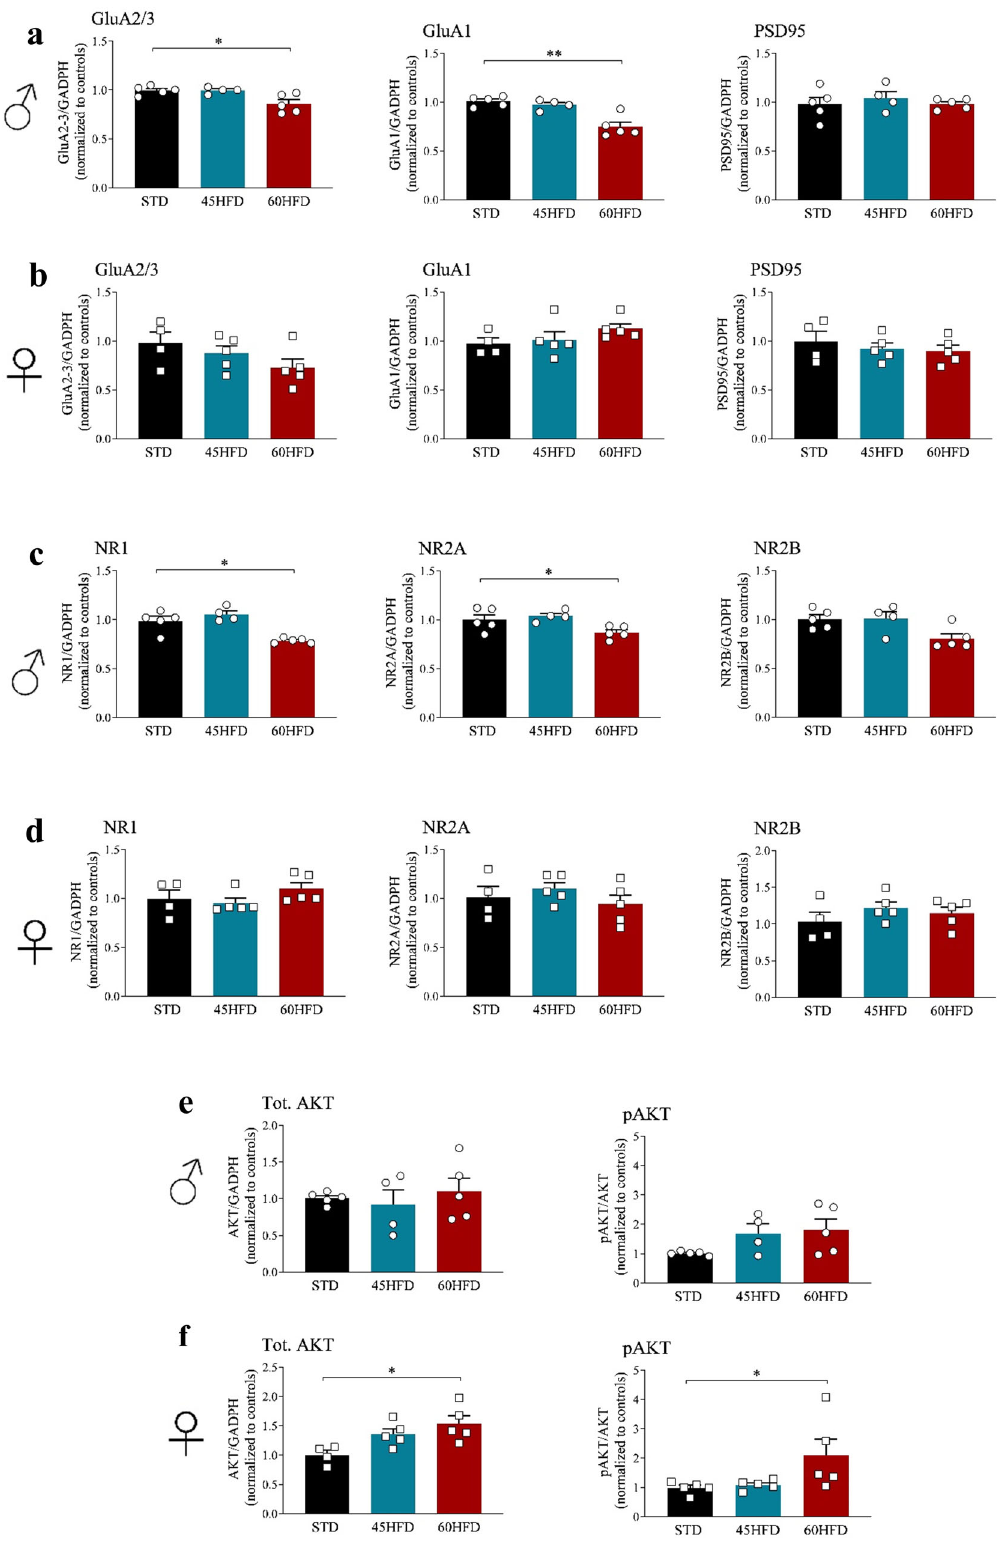
Fig. 7 Post mortem analysis of anterior cortex. a Western blot analysis of AMPA receptor subunits: GLUA2/3, GLUA1 and PSD95 protein in anterior cortex of male mice and female mice b at 33 weeks of diet. c Western blot analysis of NMDA receptors subunits NR1, NR2A, NR2B, in the anterior cortex of male and female mice d at 33 weeks of diet. e Total AKT and phosphorylated AKT in male and female mice f at 33 weeks of diet. Data are analyzed using Kruskal – Wallis test followed by Dunn ’ s post hoc test and are expressed as mean ± S.E.M. of normalization on total proteins vs control (* p ≤